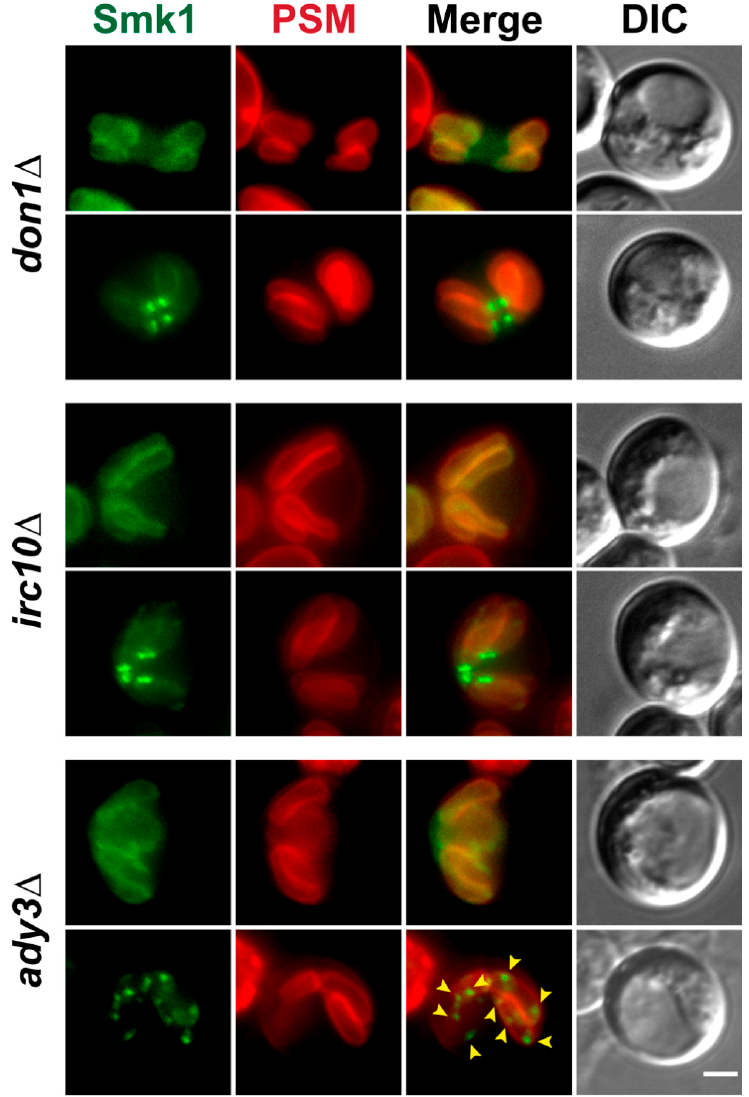
Figure 4. Smk1 localization requires the Leading Edge Protein complex member ADY3 , but not IRC10 or DON1 . Smk1-GFP ENVY is localized to the prospore membrane and the leading edge in don1 ∆ (LH1123) and irc10 ∆ (LH1124) mutants. Smk1-GFP ENVY is localized to the prospore membrane (PSM) in ady3 ∆ (LH1125) mutants early in meiosis II, but becomes localized as puncta along the leading edge later in development. Prospore membranes are in red and are labeled using an integrated Spo20 51–91 -mKate2 marker. Yellow arrowheads indicate some of the ectopic Smk1 puncta seen along the prospore membrane in ady3 ∆ mutant cells. Scale bar = 2 µM.